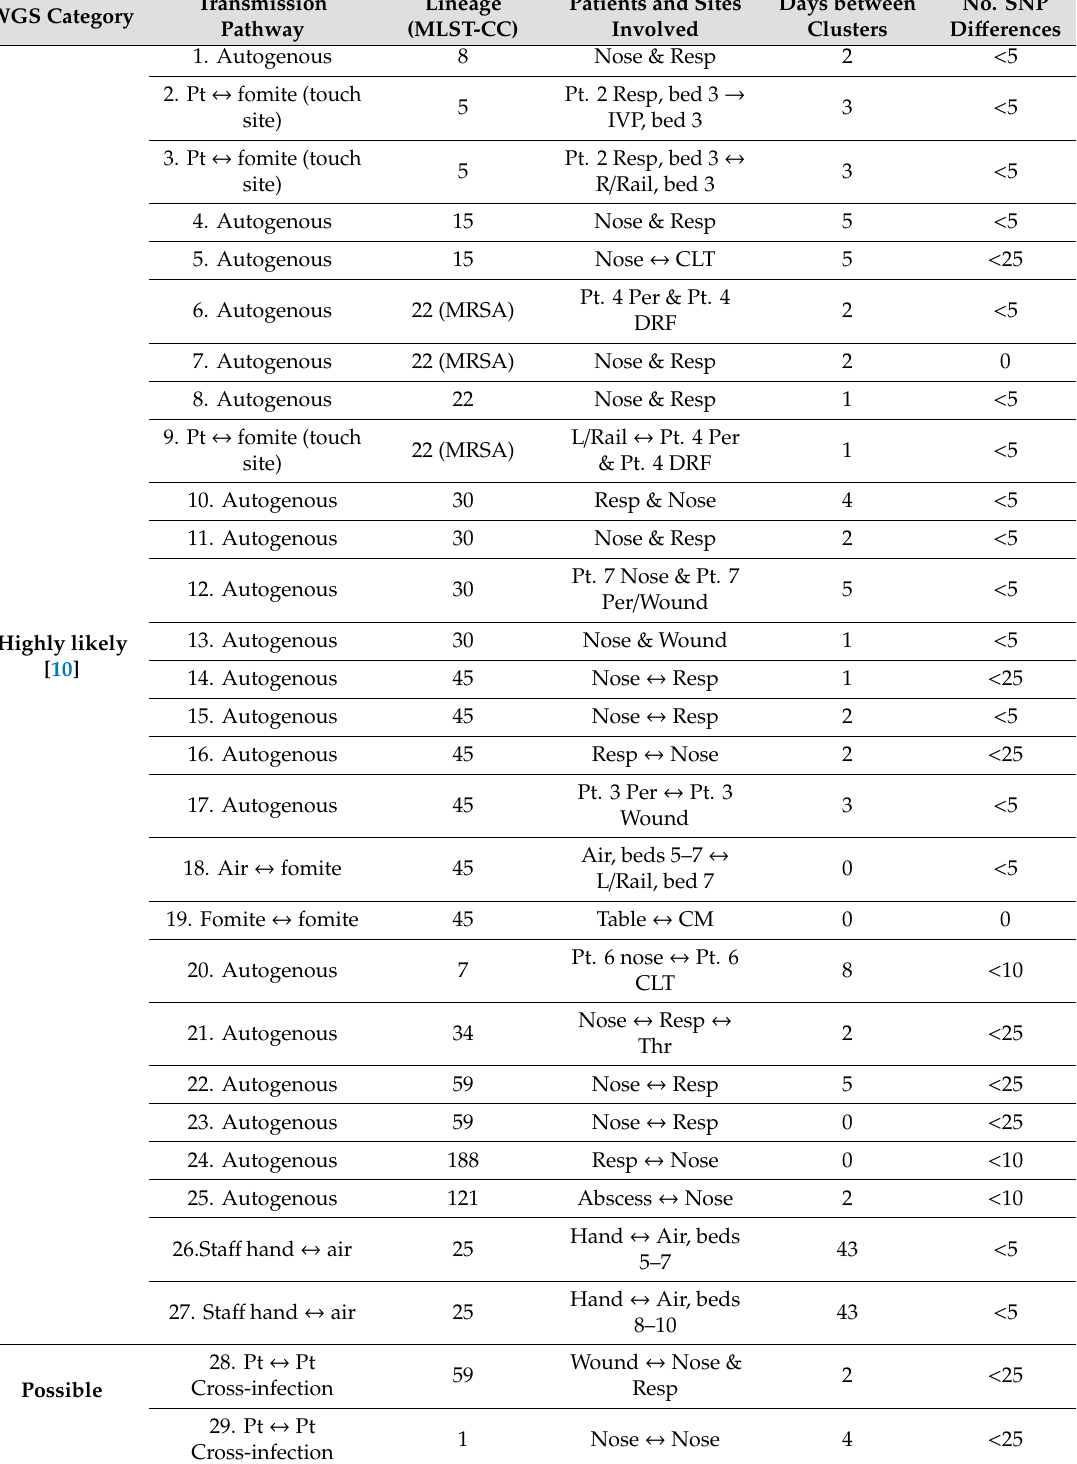
Table 3. Whole-genome sequencing (WGS) categories and pathways, lineage, sites, intervals (days) and SNP (single-nucleotide polymorphism) di ff erences of S. aureus clusters in a ten-bed ICU during a ten month